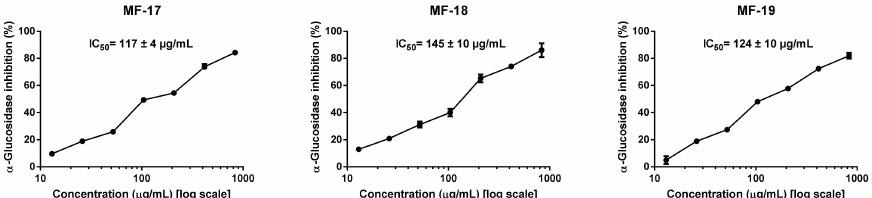
Figure 4. α -Glucosidase inhibition of phenol-rich extracts from ‘Mansa de Figueiredo’ EVOOs (MF-17, MF-18, and MF-19) obtained at three successive harvests. Results show the mean ± SD of 3 experiments of inhibition × 3 different phenolic extracts × 3 olive oils ( n = 27 per crop